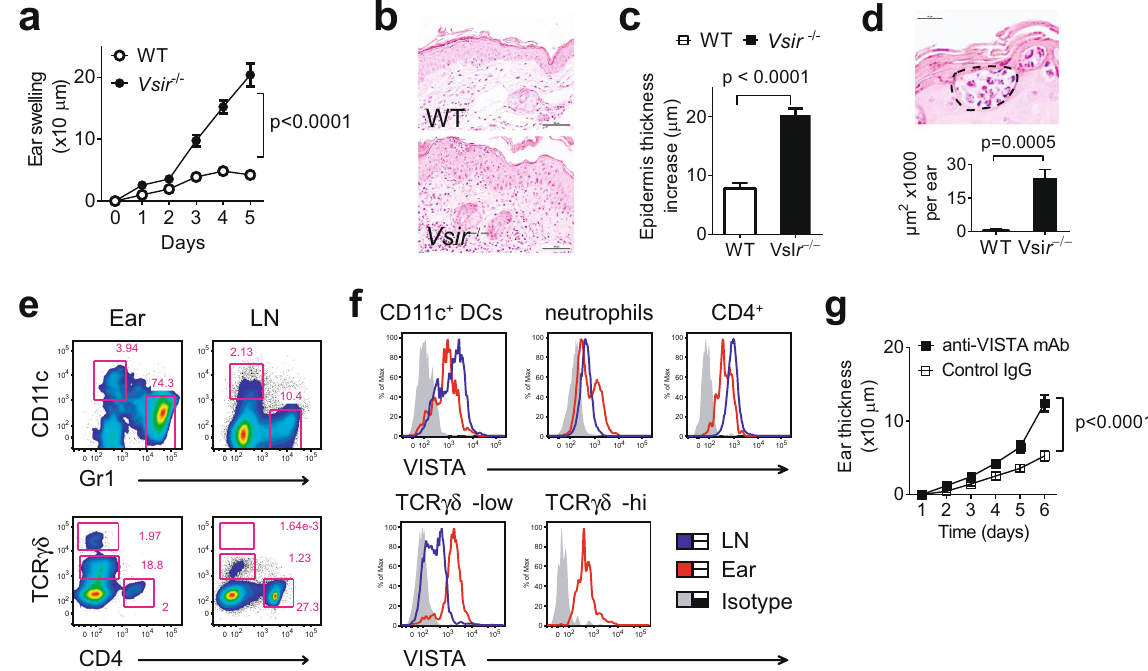
Figure 1. VISTA deficiency exacerbated the IMQ-induced psoriasiform inflammation. ( a ) WT and Vsir − / − mice were topically treated daily on each ear with 3.5% IMQ cream for 5 days. Ear thickness was measured daily. Ear swelling is shown as the increase of ear thickness when compared to day 0, and expressed as mean ± SEM (n = 18). On day 5, ears were harvested and processed for H&E staining. A representative image is shown ( b ). Scale bars: 50 μ m. ( c ) The epidermal thickness was measured by examining at least 20 random fields throughout the cross section of ear tissues. The increase of epidermal thickness was calculated by subtracting the average value of naive ears. Data are pooled from 3 ears and shown as mean ± SEM. ( d ) A representative image of Munro’s abscess in epidermis is shown (within the dashed lines). Scale bar: 50 μ m. Areas of Munro’s abscess were measured from the entire cross section of ear tissues. Data are pooled from 3 ears and shown as ± SEM. ( e ) The number of CD11c + DC, Gr1 + neutrophils, γδ TCR + and CD4 + T cells in IMQ-treated ears and ear- draining LN in WT mice was examined by flow cytometry. ( f ) Surface VISTA expression on these cell types was examined by flow cytometry. Representative data from at least three independent experiments are shown. ( g ) WT mice were treated with VISTA-specific mAb or control Ig (250 μ g, on day 0, 2, and 4), in addition to the 3.5% IMQ cream. Ear swelling is shown as mean ± SEM (n =